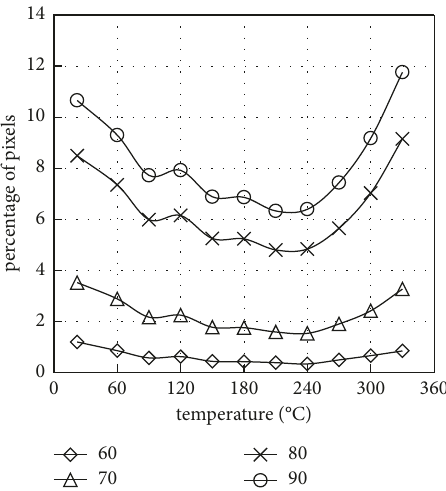
Figure 4: The graph for pixel percent of fine sandstone samples at different